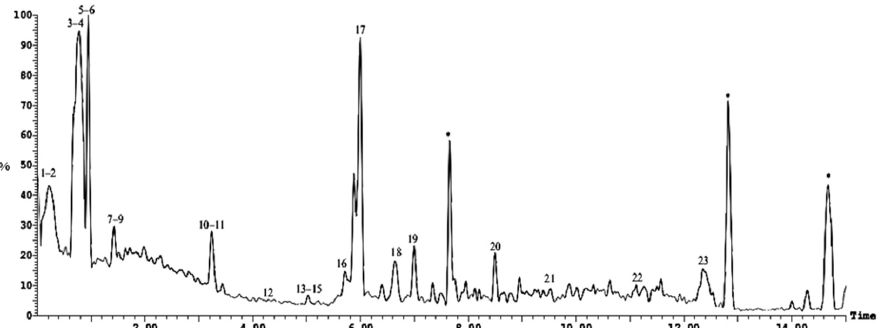
Figure 7. UPLS-ESI-MS chromatogram of ethyl acetate, fraction in positive (+) ionization mode * Unidentified compounds, numbers 1–24 refer to the tentatively identified compounds in ethyl acetate fraction.